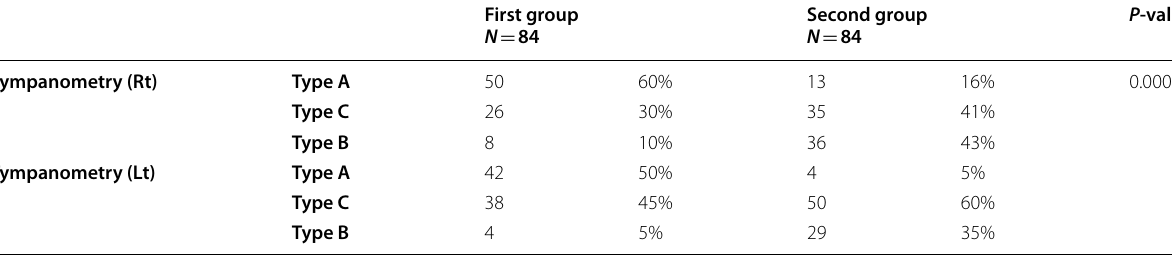
Chi-square test: * statistically significant